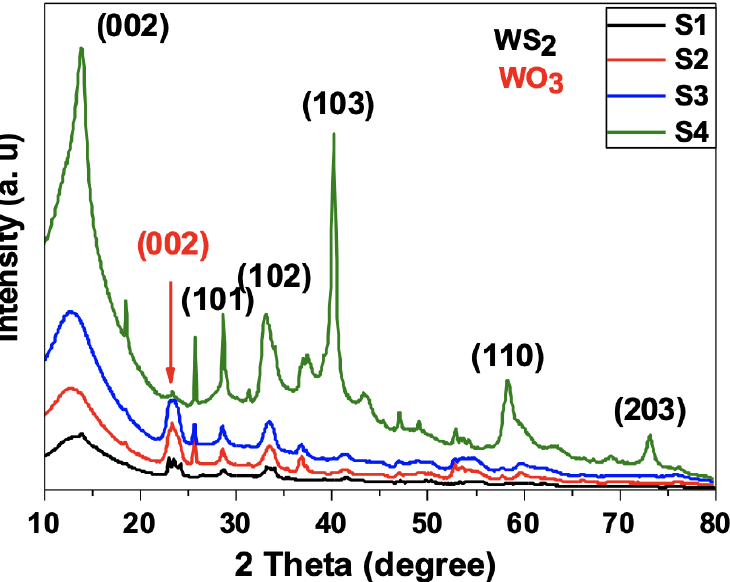
Figure 3. XRD diagrams for the four processed samples. Note the absence of WO 3 peak in sample S4 indicating the high purity WS 2 nanosheets.